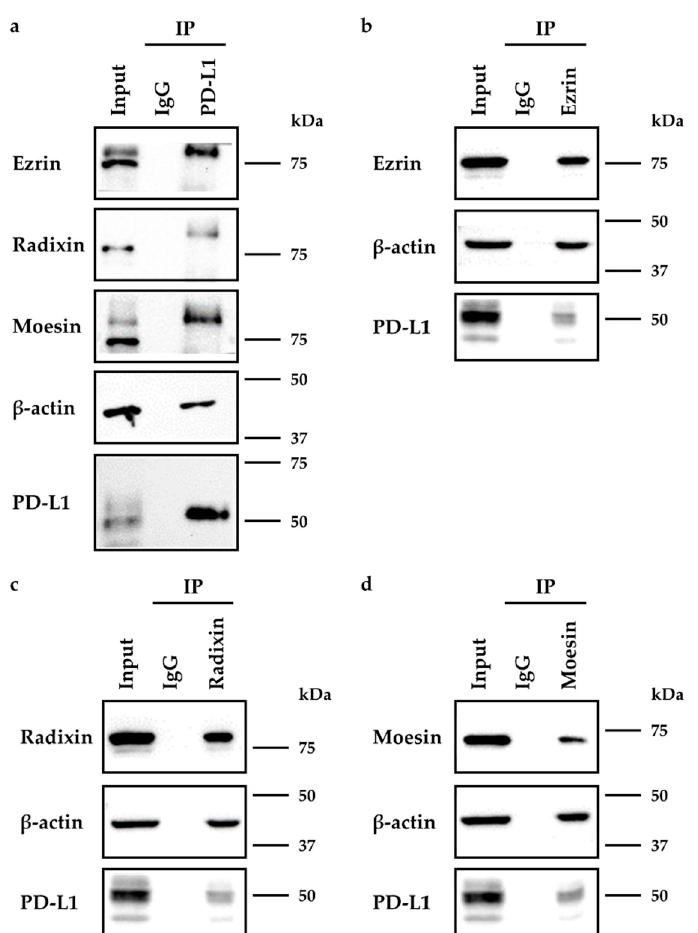
Figure 4. Immunoprecipitation analysis to detect the protein–protein interactions between pro- grammed cell death ligand-1 (PD-L1) and ezrin/radixin/moesin (ERM) in HeLa cells. The whole-cell lysates of HeLa cells were immunoprecipitated with antibodies against ( a ) PD-L1, ( b ) ezrin, ( c ) ra- dixin, ( d ) moesin, or control antibody. Western blot images of ezrin, radixin, and moesin as well as PD-L1, in addition to β -actin, in the whole-cell lysates (input) and those co-immunoprecipitated (IP) with a control IgG or each antibody, are shown. Molecular weights are indicated in kDa.